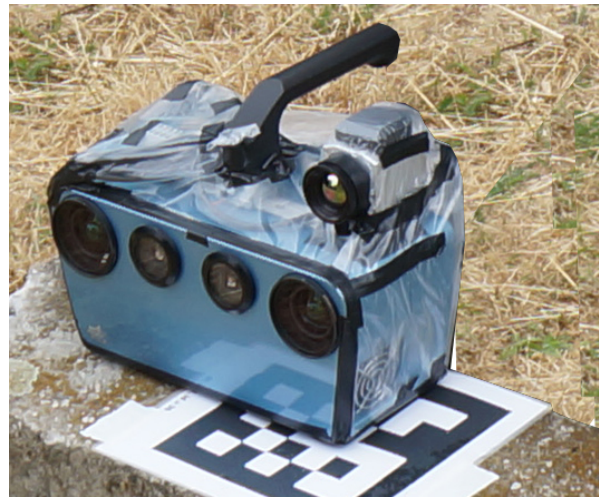
Figure 1. Trifocal IPS with a thermal (on top) and two visual cameras (front). Table 1. Camera specifications of the integrated positioning system